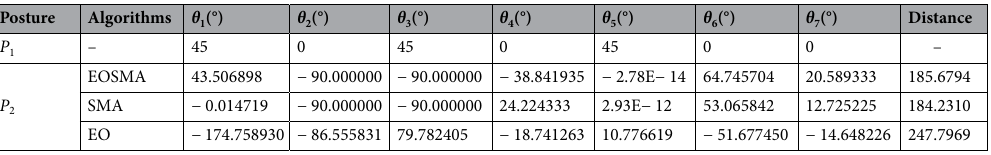
Table 9. Inverse solution results of the 7-DOF robotic manipulator.